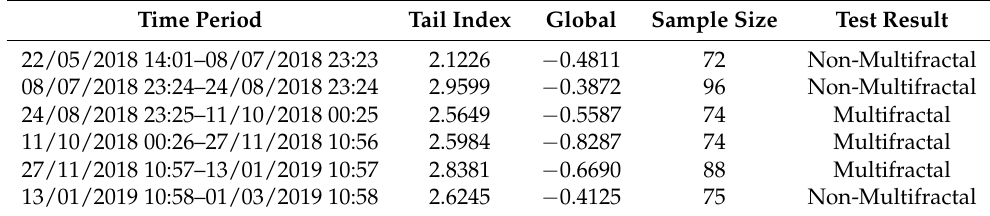
Table A5. Global Hypothesis test results on high frequency Bitcoin open